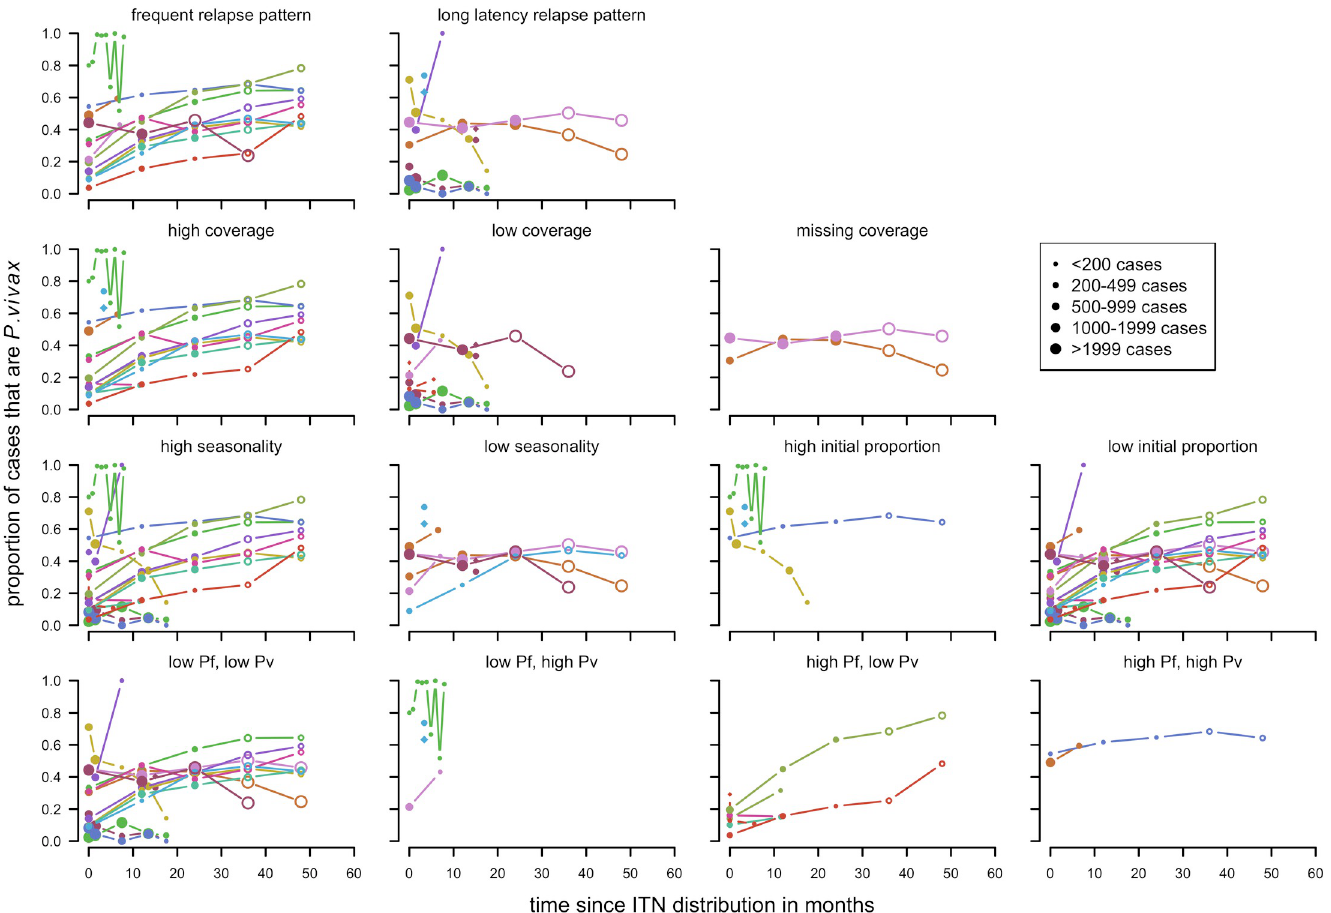
Fig 9. Spaghetti plots splitting the series of time-points of the proportion of cases with P. vivax infection by relapse pattern, coverage, seasonality, initial proportion of P. vivax and transmission intensity after first time ITN distribution. Dot size depending on number of infections.